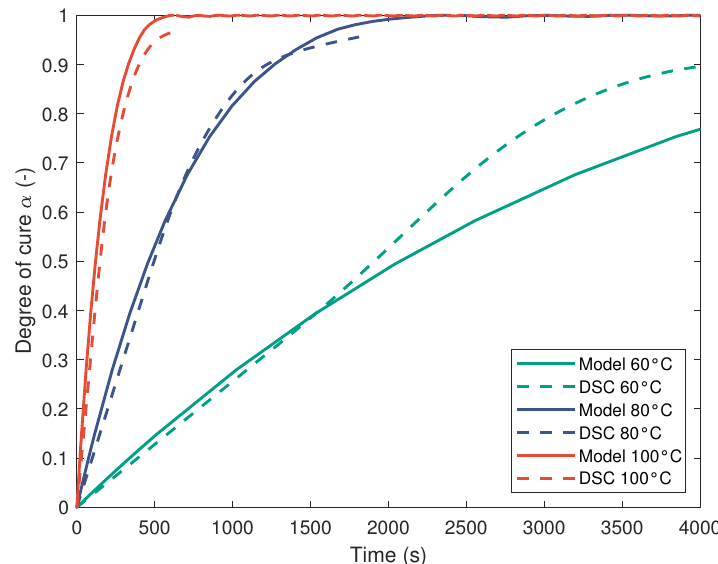
Figure 6. Degree of cure α as a function of time fitted to isothermal DSC